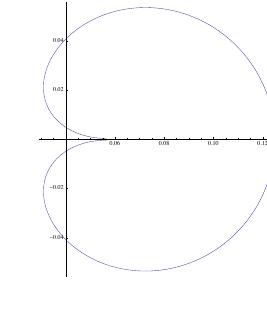
Figure 1: Sample curves in the left and right cases